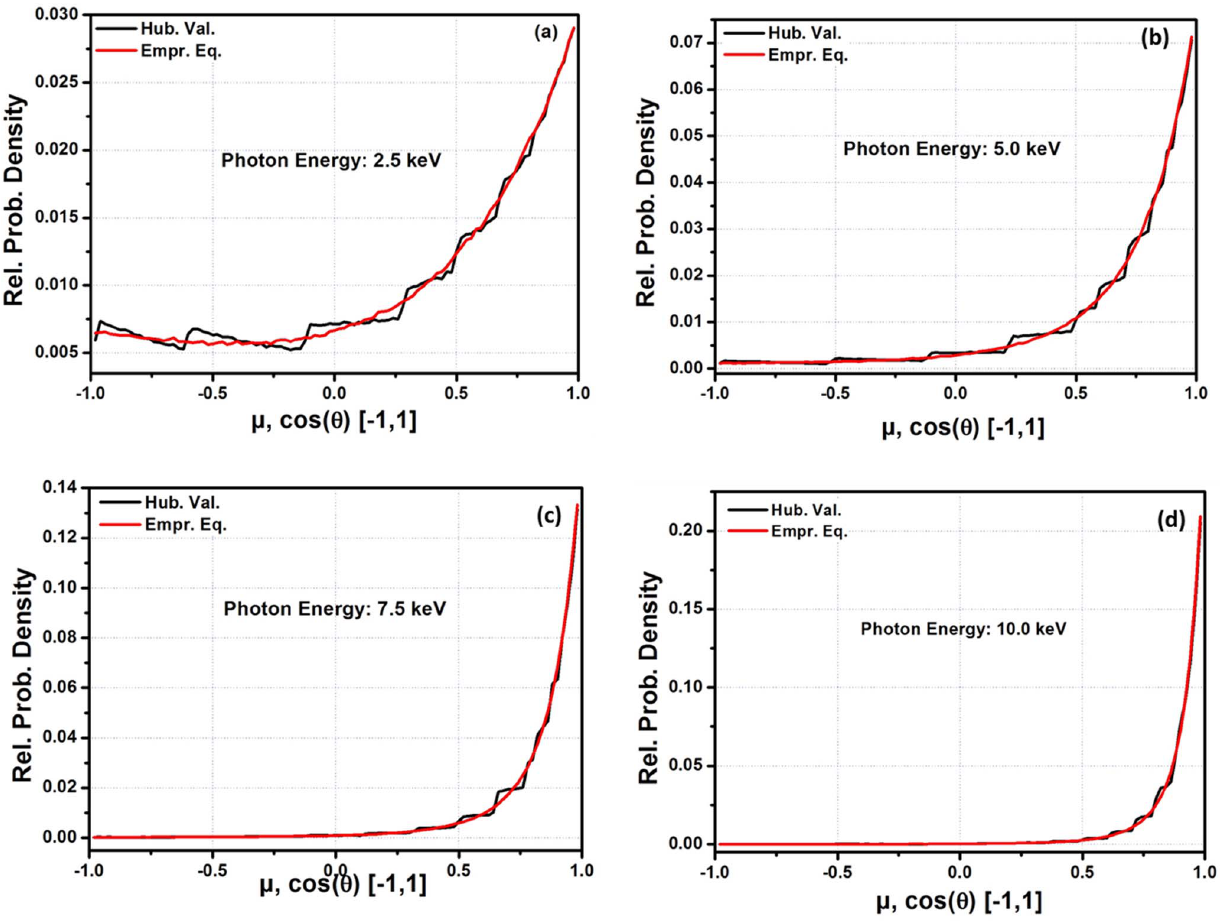
Figure 3. Angle distribution of coherently scattered photons for a source of 1 million photons by using F H ( q i , Z ) for ‘ q ’ from 0 to 16.0 A˚ 2 1 and Empirical equation data for Hydrogen (H, Z=1) as a scatter element. (a) energy=0.0025 MeV, (b) energy=0.005 MeV, (c) energy=0.0075 MeV, (d) energy=0.01 MeV.